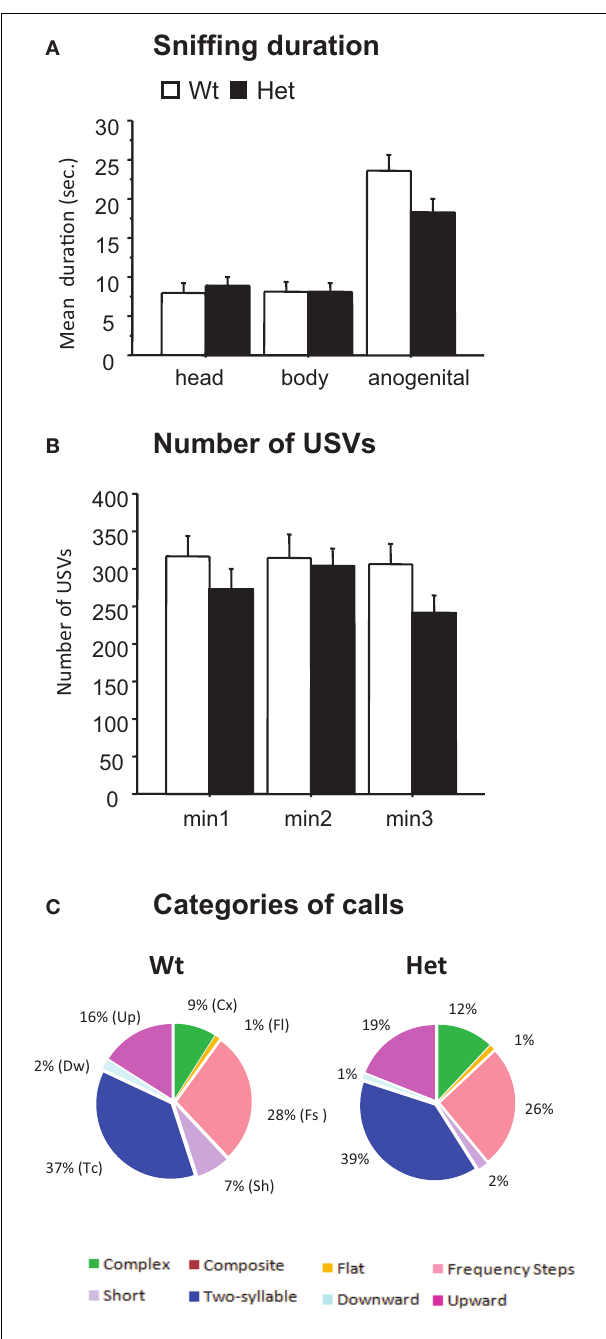
FIGURE 2 | Male–female social interaction test (3-min-session) performed in 3-month-old reeler mutant mice . Parameters measured during a direct interaction between a male with a sexually receptive C57BL/6J female. (A) Sniffing duration. (B) Number of ultrasonic vocalizations. Data are expressed as mean + SEM. (C) Pie graphs show the percentages of the different call categories emitted byWt and Het reeler mice. Percentages were calculated in each genotype as number of calls in each category for each subject/total number of calls analyzed for each subject. Number of calls analyzed: 17195 inWt and 8454 in Het. N = 9Wt and N = 21